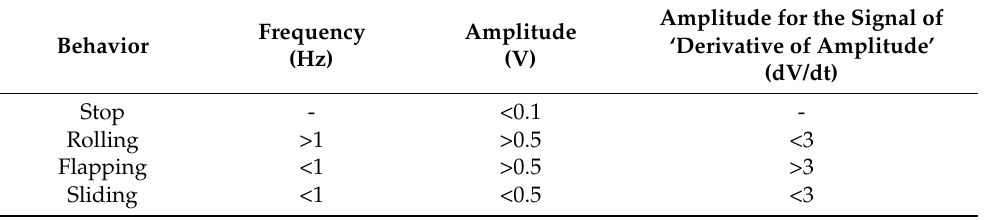
Table 2. Summary of criteria on identification for the function of ‘Is Low?’ in terms of frequency, amplitude, and amplitude for the signal of ‘derivative of amplitude